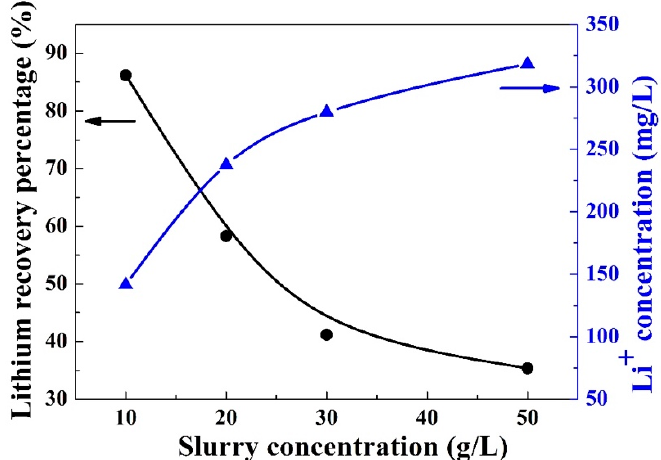
Figure 6. Lithium recovery percentage (round symbol) and Li + concentration in the filtrate (triangle symbol) from LiAl-LDHs-1 slurry at varying concentrations of 10 g/L, 20 g/L, 30 g/L, 50 g/L.